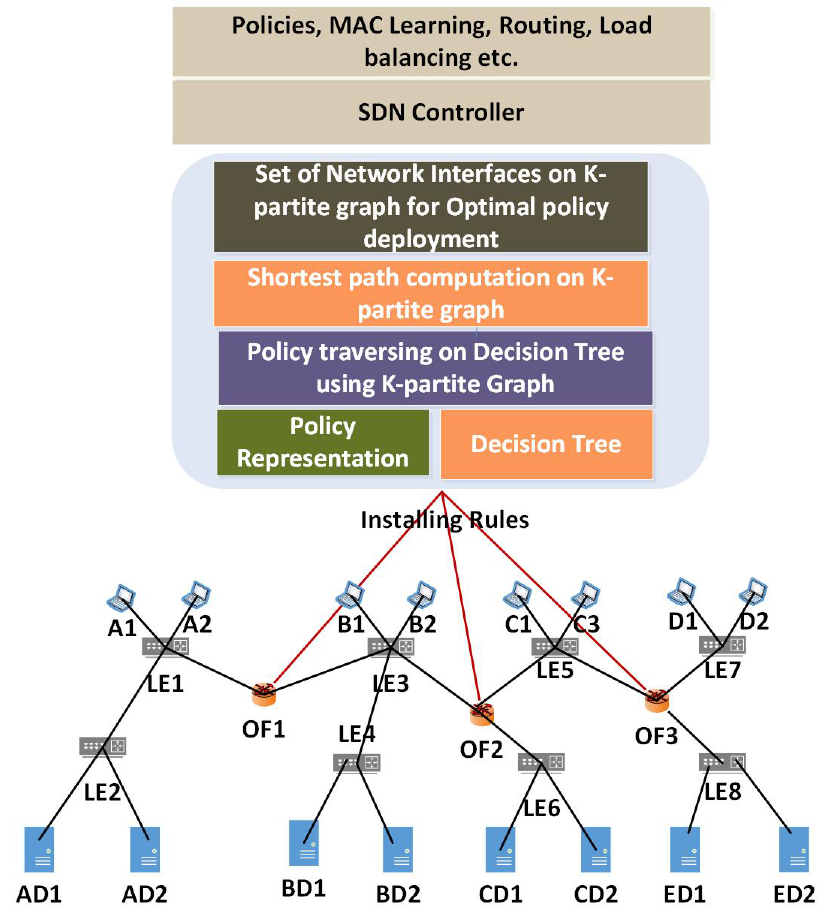
Figure 10. Entire System